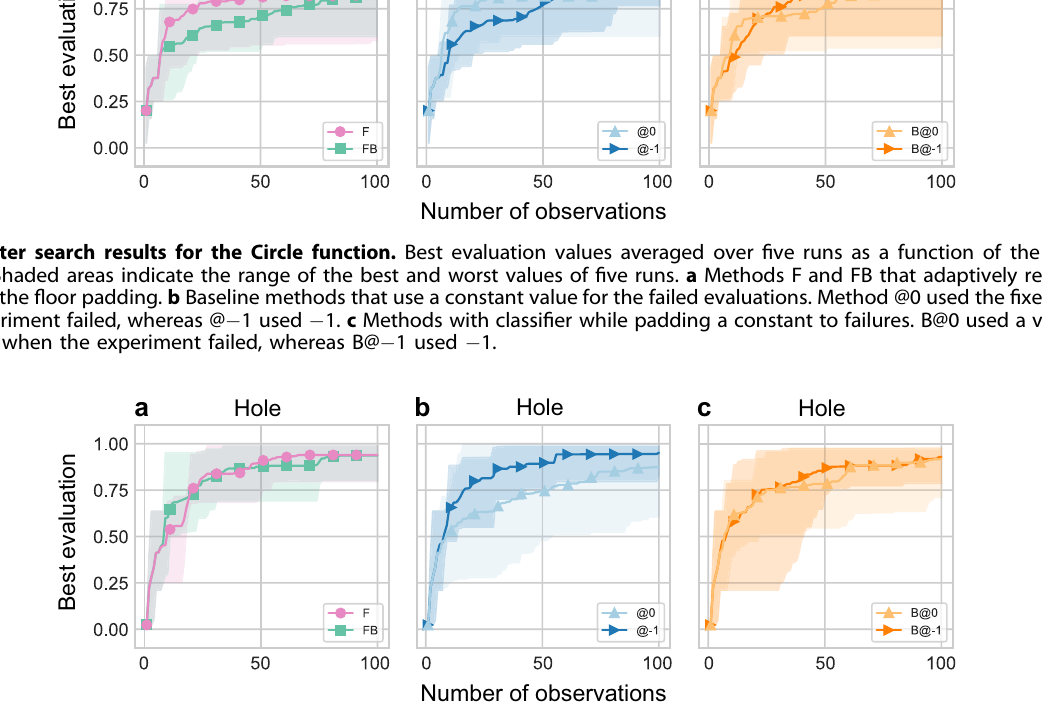
Fig. 3 Parameter search results for the Hole function. Best evaluation values averaged over fi ve runs as a function of the number of observations. Shaded areas indicate the range of the best and worst values of fi ve runs. a Methods F and FB that adaptively replace failed evaluations by the fl oor padding. b Baseline methods that use a constant value for the failed evaluations. Method @0 used the fi xed value of 0 when the experiment failed, whereas @ − 1 used − 1. c Methods with classi fi er while padding a constant to failures. B@0 used a value of 0 as the evaluation when the experiment failed, whereas B@ − 1 used −